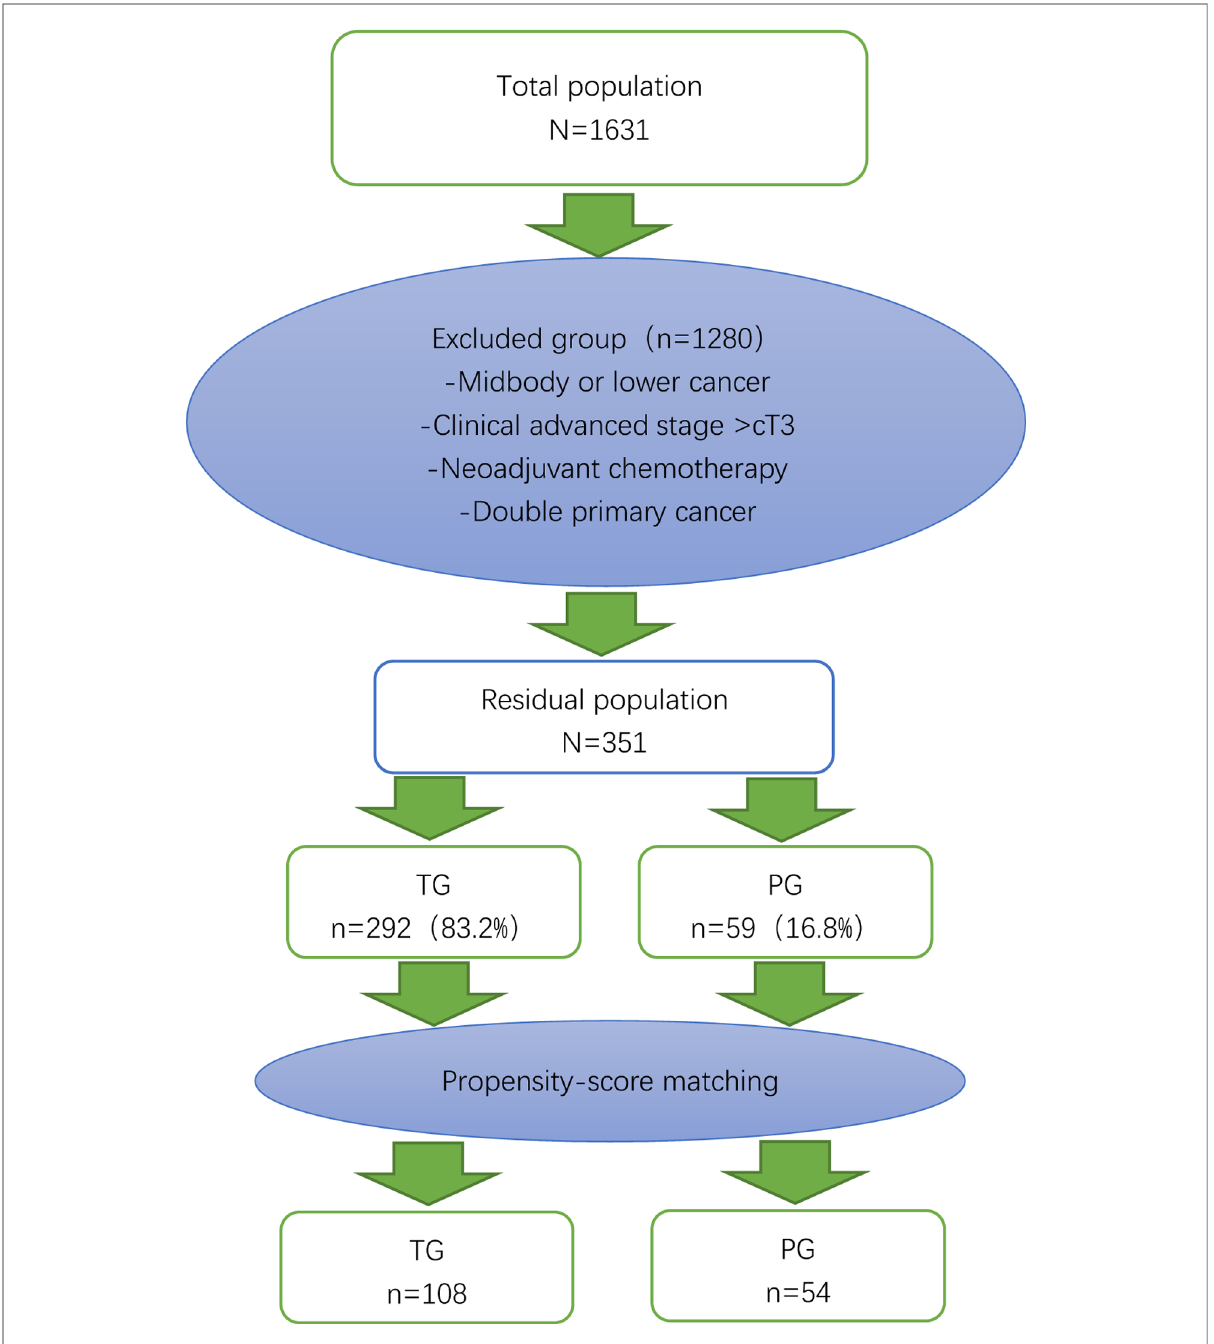
FIGURE 3 Flow chart of patient selection and propensity score matching. The 54 patients who underwent proximal gastrectomy (PG) were matched to 108 patients who underwent total gastrectomy (TG) in terms of age, sex, body mass index, clinical stage, and American Society of Anesthesiologists (ASA)